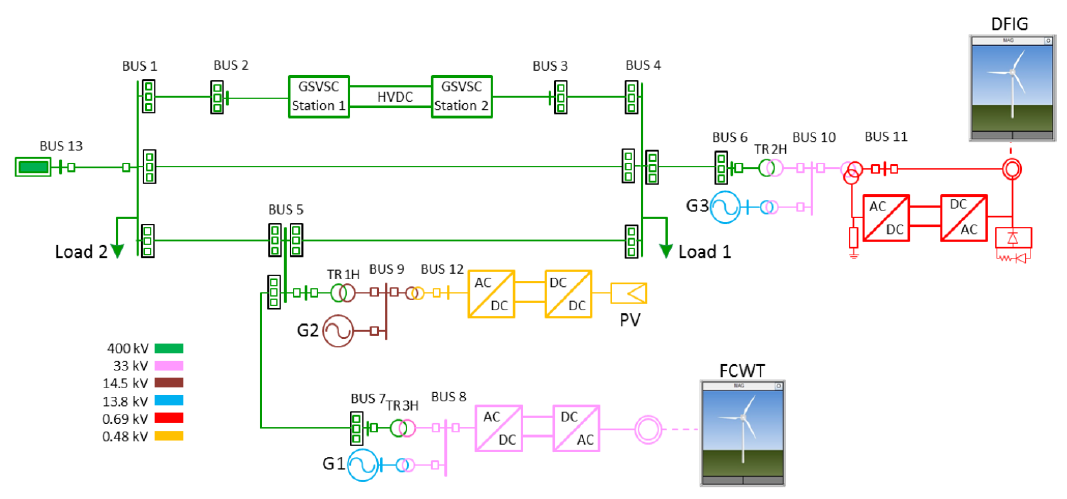
Figure 2. Benchmark